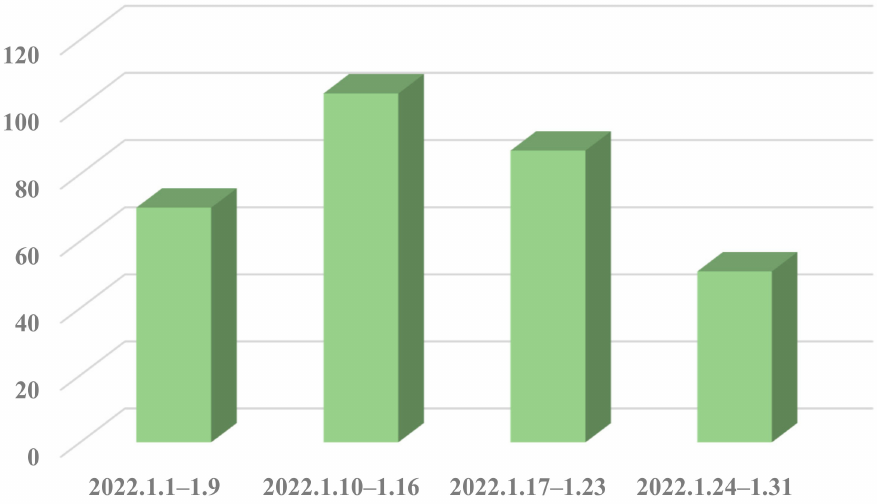
Figure 2. Number of questionnaires collected over